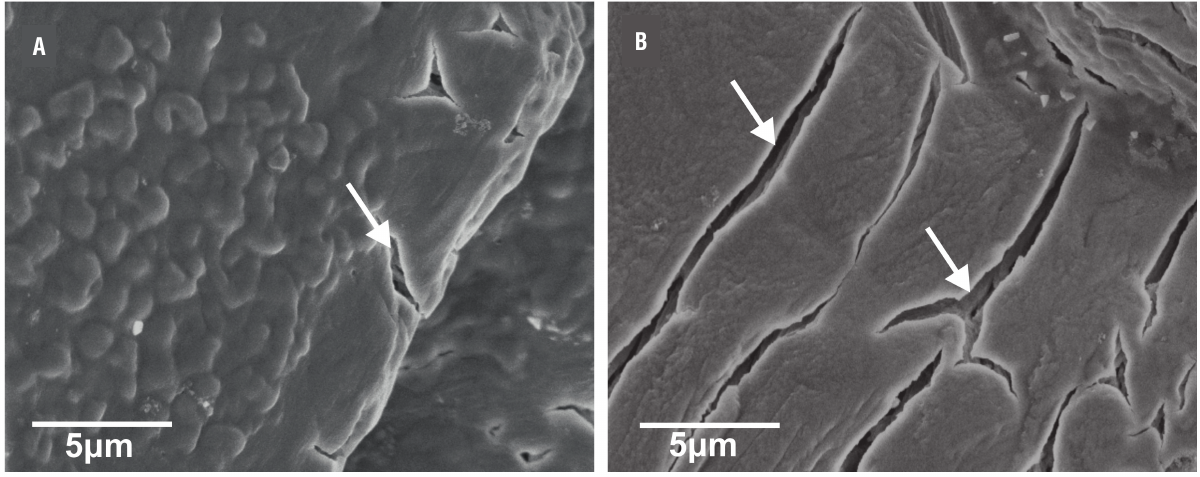
Figure 6 - FE-SEM micrographs of struvite crystals grown in artificial urine infected with Pseudomonas aeruginosa revealing the porous structure and mesoscopic arrangement (a) control (b) in presence of vitamin C (1 mg/mL). Arrow indicates porous